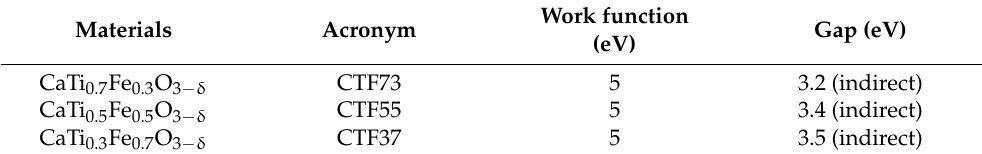
Table 3. Work Functions Measured on CaTi 1 − y Fe y O 3 − δ Perovskite